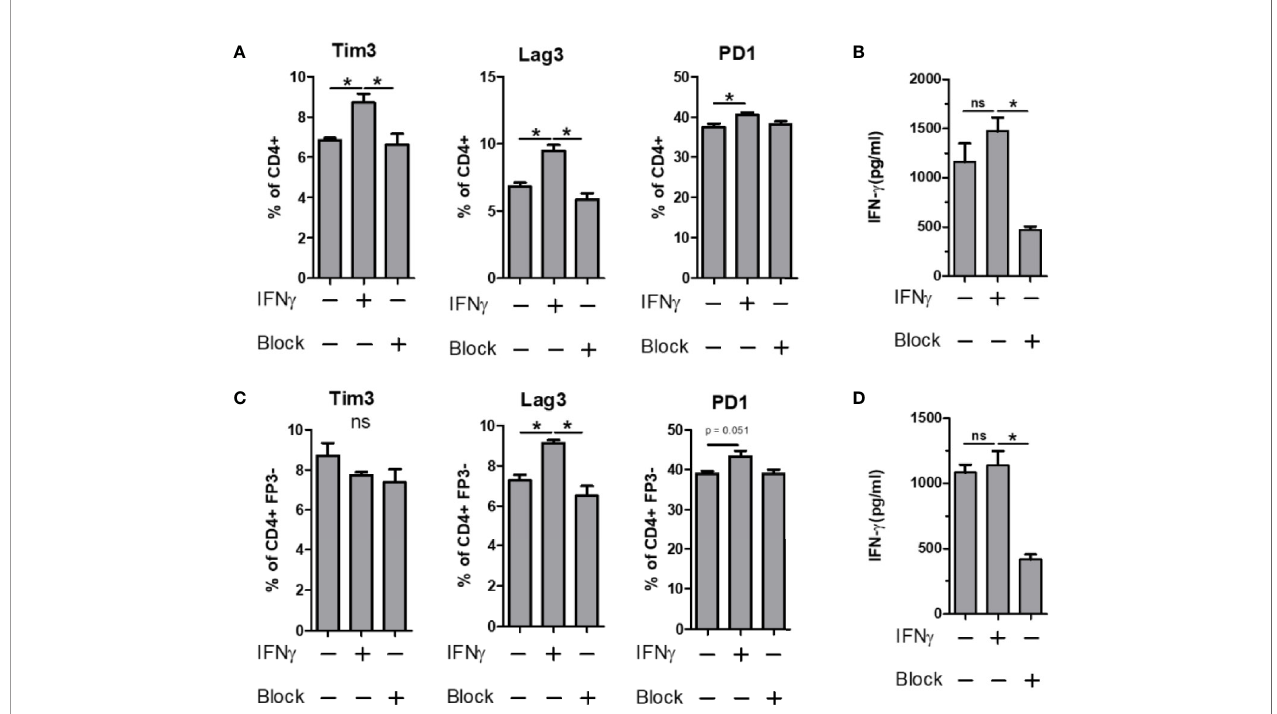
FIGURE 6 | IFN- g in fl uence on immunomodulatory marker expression. Bulk or FP3 − CD4 + T cell were cultured in vitro for 3 days with a CD3 stimulation. Cells were supplemented with 10 ng/ml of recombinant mouse IFN- g or with 10 µg/ml of a -IFN- g blocking antibody. Marker expression assays with fl ow cytometry and culture supernatants were used for ELISA. Tim3, Lag3 and PD1 expression of (A) Bulk or (C) FP3 − CD4 + T cells with or without IFN or antibody blockade. ELISA data of culture supernatants from (B) Bulk or (D) FP3 − CD4 + T cell cultures. (signi fi cance of P ≤ 0.05 =